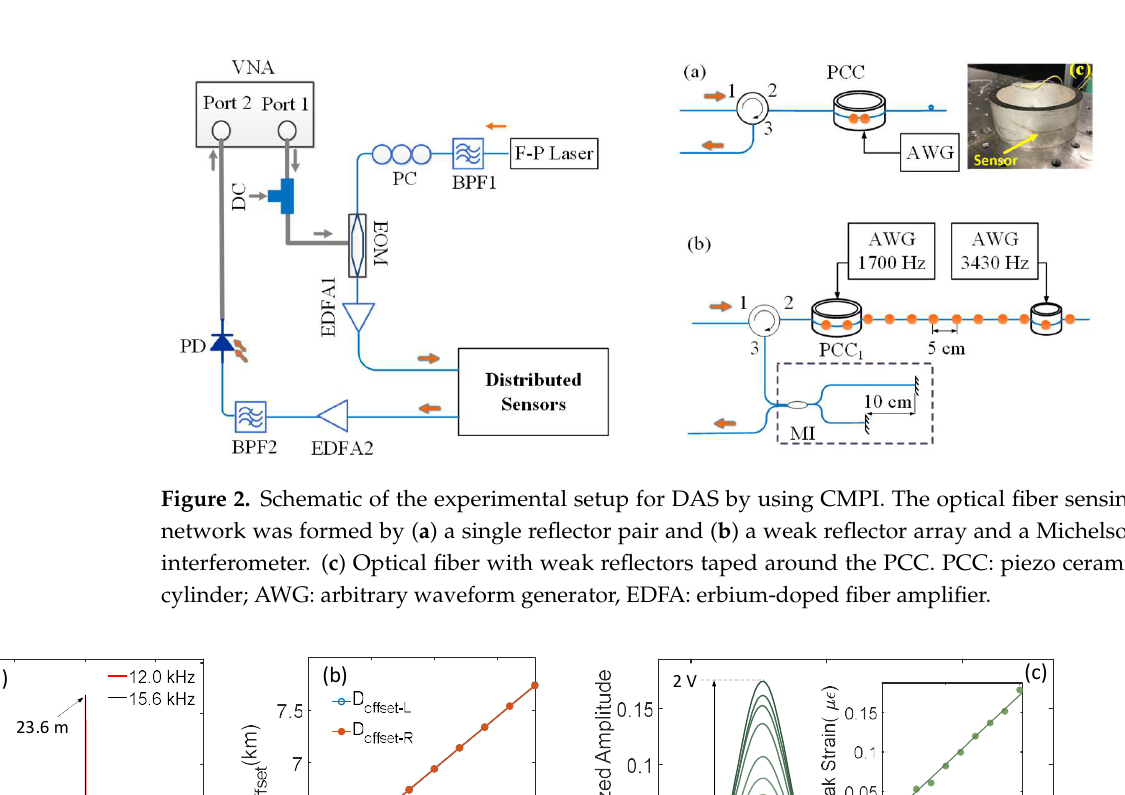
Figure 2. Schematic of the experimental setup for DAS by using CMPI. The optical fiber sensing network was formed by ( a ) a single reflector pair and ( b ) a weak reflector array and a Michelson interferometer. ( c ) Optical fiber with weak reflectors taped around the PCC. PCC: piezo ceramic